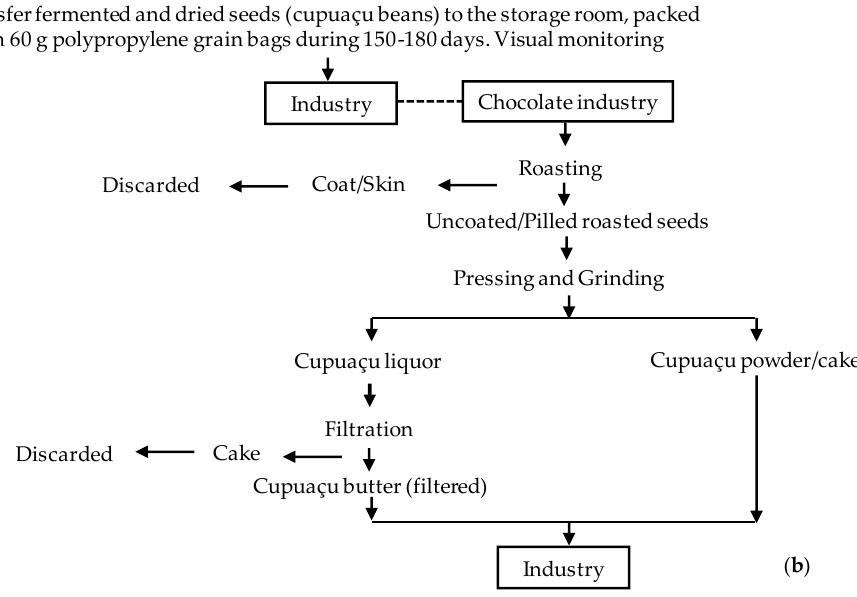
Figure 2. Flowchart for the production of cupuaçu ( a ) seeds and ( b ) fermented and dried seeds with coating (skin).